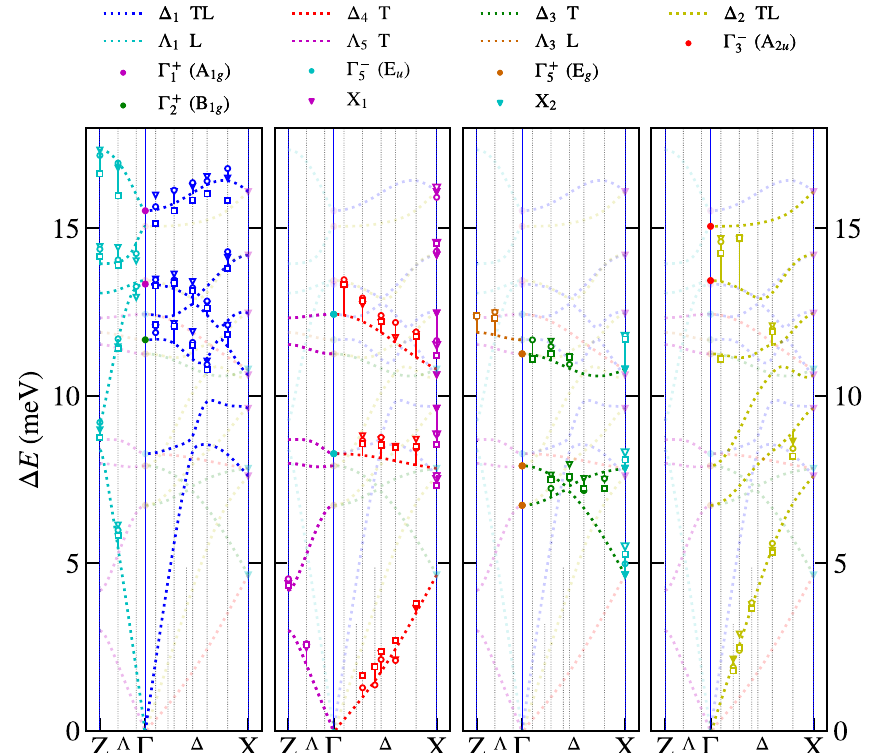
Figure 7. The comparison of theoretical calculation with the fit of measured inelastic X-ray scattering spectra for LaPd 2 Al 2 in energy range 0 - 17.5 meV. The (cid:31) , ○ , ▽ symbols correspond to 1.5, 80, 300 K, respectively. For details of the fit, see chapter Results - Phonon dispersion curves in (Ce,La)Pd 2 Al 2